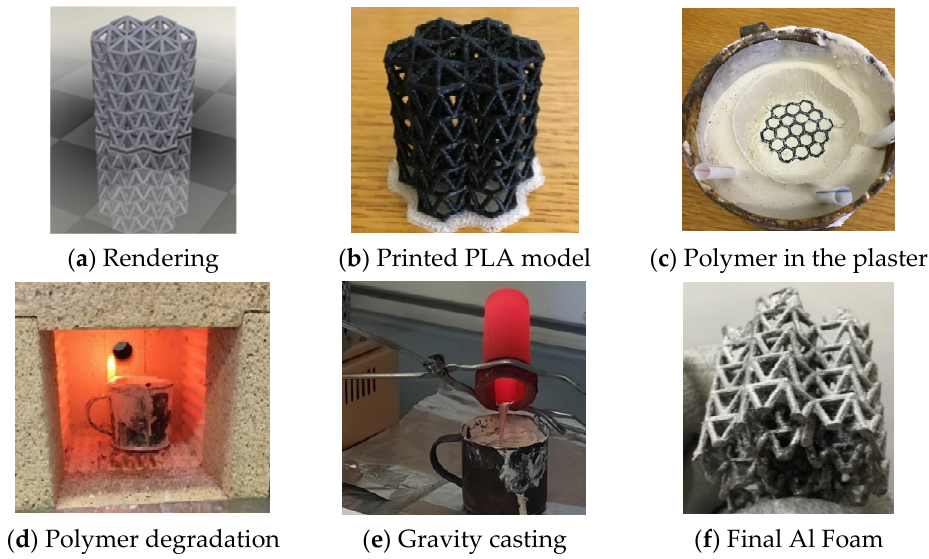
Figure 6. The six steps of the foam manufacturing process: ( a ) rendering of the model; ( b ) printing of the model; ( c ) polymer in the plaster; ( d ) polymer degradation; ( e ) gravity casting; ( f ) final Al foam.